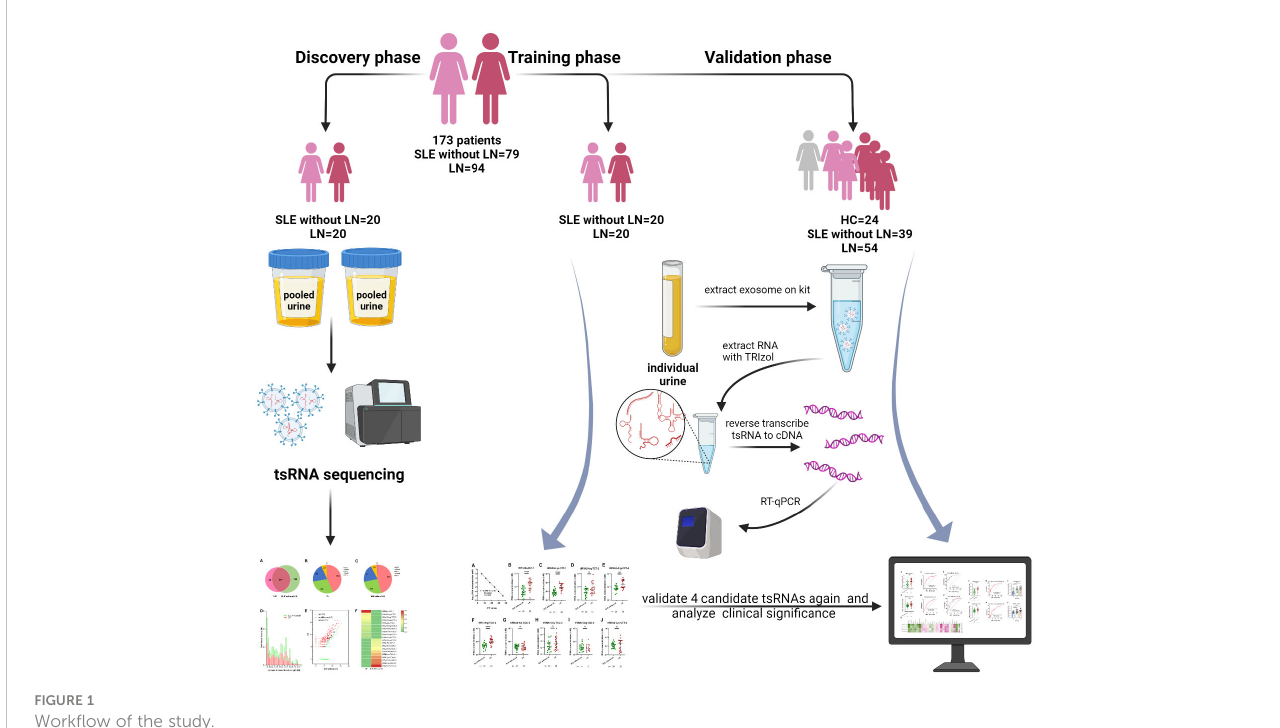
FIGURE 1 Work fl ow of the